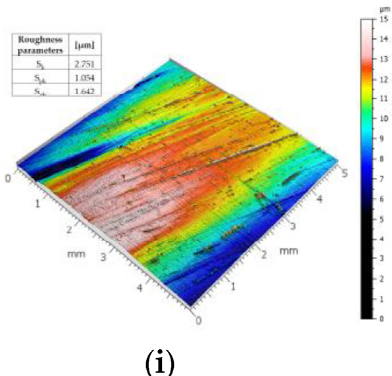
Figure 6. The 3D roughness profiles of the tested materials’ surfaces: ( a ) Hardox 500 worn in light soil, ( b ) Hardox 600 worn in light soil, ( c ) Hardox Extreme worn in light soil, ( d ) Hardox 500 worn in medium soil, ( e ) Hardox 600 worn in medium soil, ( f ) Hardox Extreme worn in medium soil, ( g ) Hardox 500 worn in heavy soil, ( h ) Hardox 600 worn in heavy soil, ( i ) Hardox Extreme worn in heavy soil.